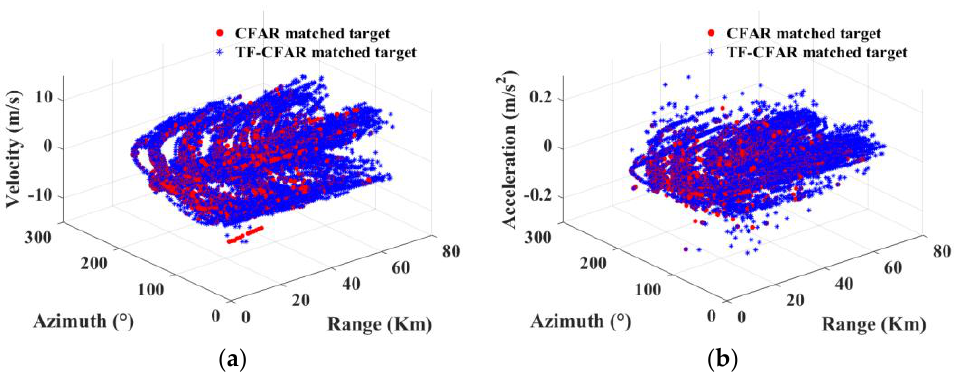
Figure 11. The 3D distribution of vessel’s azimuth, range, speed, and acceleration on 25 September 2015. ( a ) 3D distribution of vessel’s azimuth, range, and speed on 25 September; ( b ) as ( a ) but one of the dimensions is acceleration.